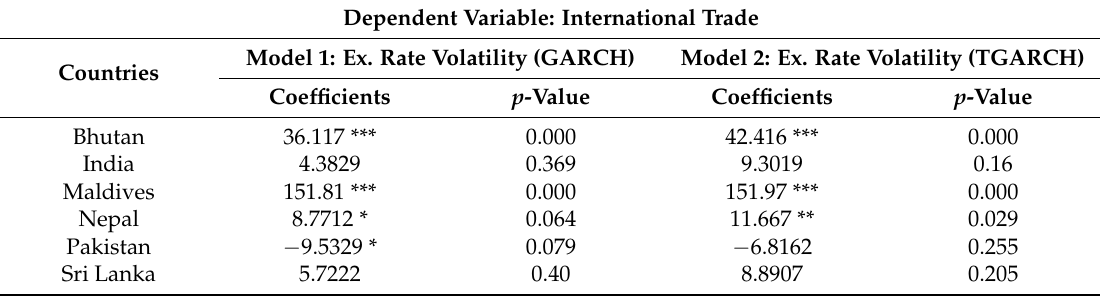
Table 7. International Trade and Exchange Rate Volatility: Country-Wise Estimation.